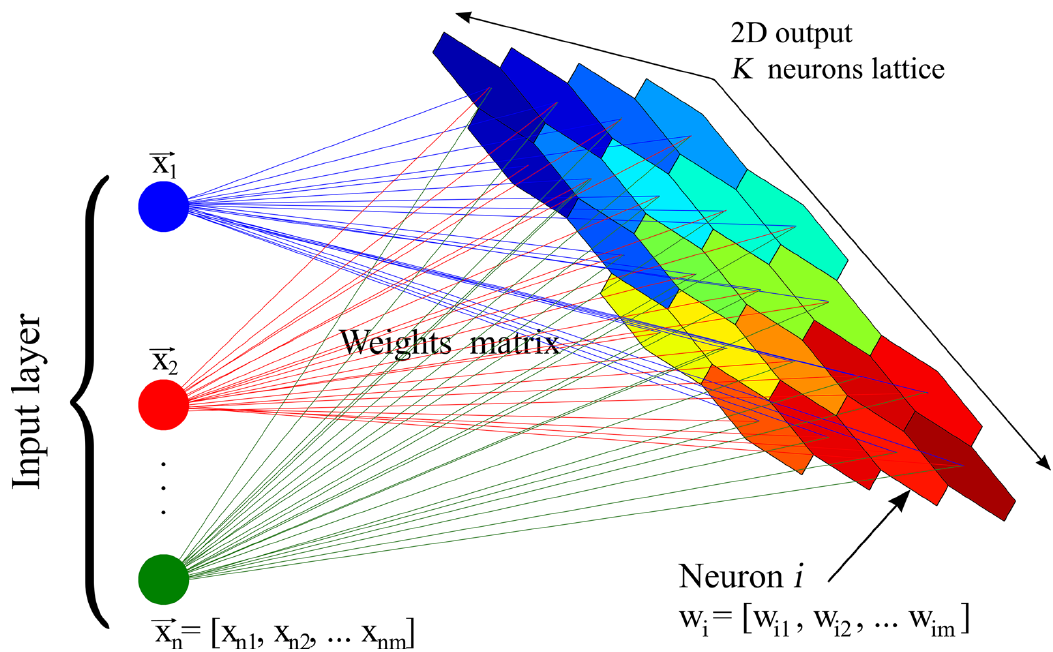
Figure 2. The basic structure of the Self-Organizing Map Neural Network [38].